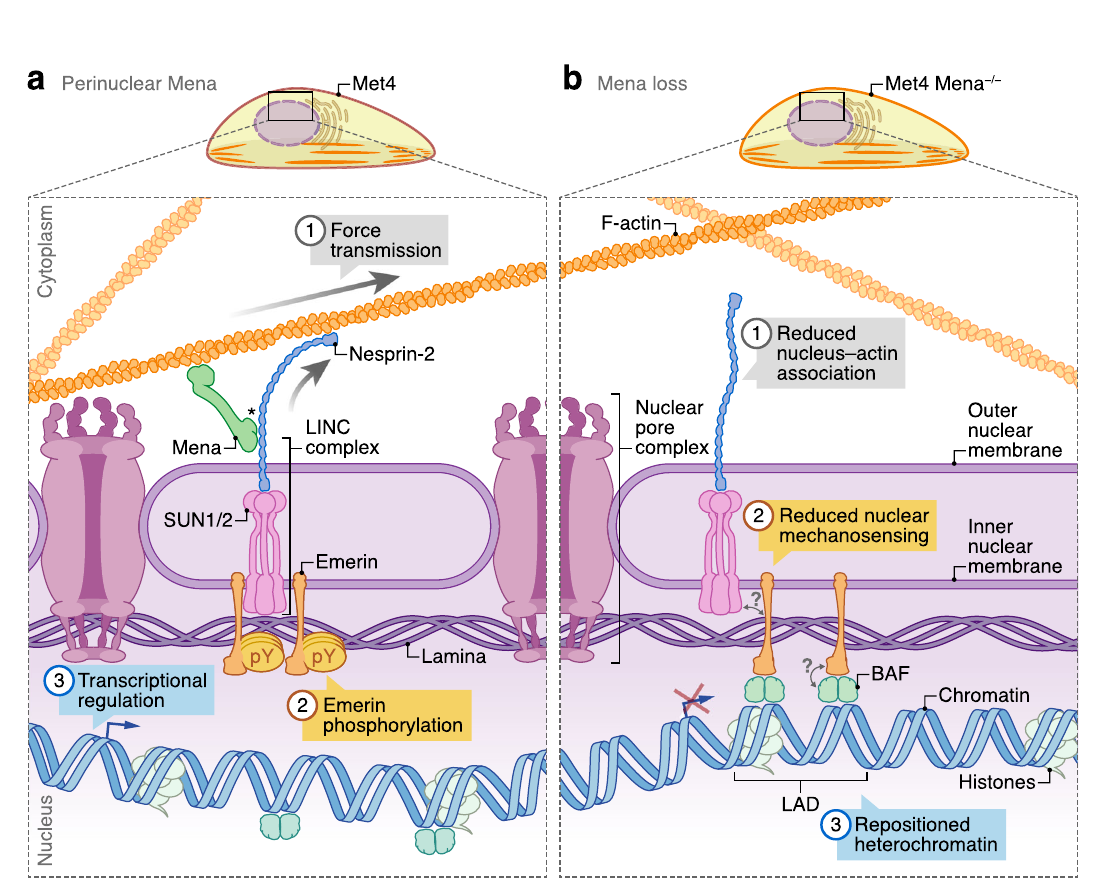
Fig. 5 | Model of the proposed role for Mena at the nuclear membrane. a Mena interacts with nesprin-2 at the outer nuclear membrane via the C-terminal SRs of nesprin-2. This potentiates the interactions of nesprin-2 with F-actin and lamin A/ C, permitting force transmission from the actin cytoskeleton to the nuclear lamina (1). Actomyosin-based force maintains emerin tyrosine phosphorylation. Emerin tyrosine phosphorylation has been reported to prevent its LAP2 – emerin – MAN1 (LEM) domain from binding to the DNA-binding protein barrier-to-autointegration factor (BAF), limiting chromatin repositioning to the nuclear lamina (2). This proposed mechanism allows genomic loci to favour chromatin decondensation and expression of speci fi c genes, including, in meta- static Met4 cSCC cells, those involved in cancer progression, such as genes associated with cell adhesion and migration (e.g. ITGA5 , PLAU ), ECM organisation (e.g. FN1 , MMP1 ) and the immune response (e.g. PTX3 , C3 ) (3). b Mena loss